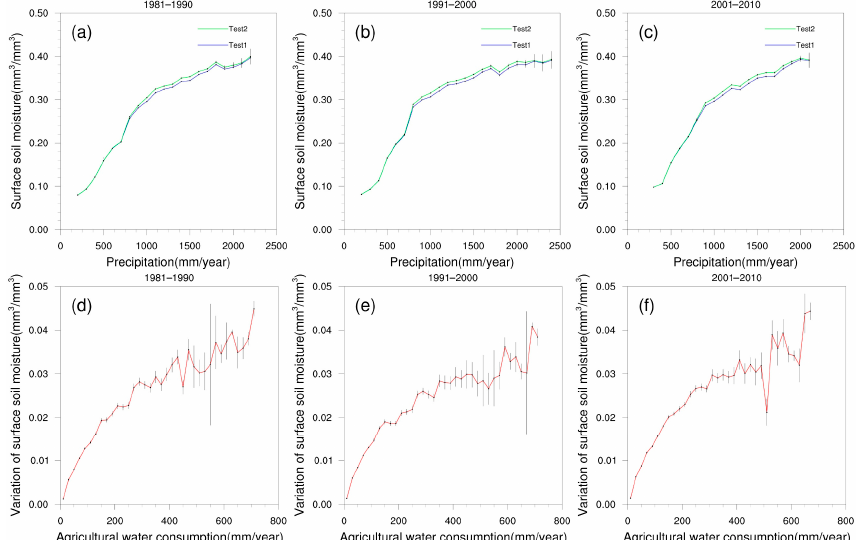
Figure 10. Effects of precipitation and agricultural water consumption on surface soil moisture and its changes. The relationship between precipitation and soil moisture in ( a ) 1980s, ( b ) 1990s and ( c ) 2000s. The relationship between agricultural water consumption and variation of surface soil moisture in ( d ) 1980s, ( e ) 1990s and ( f ) 2000s.